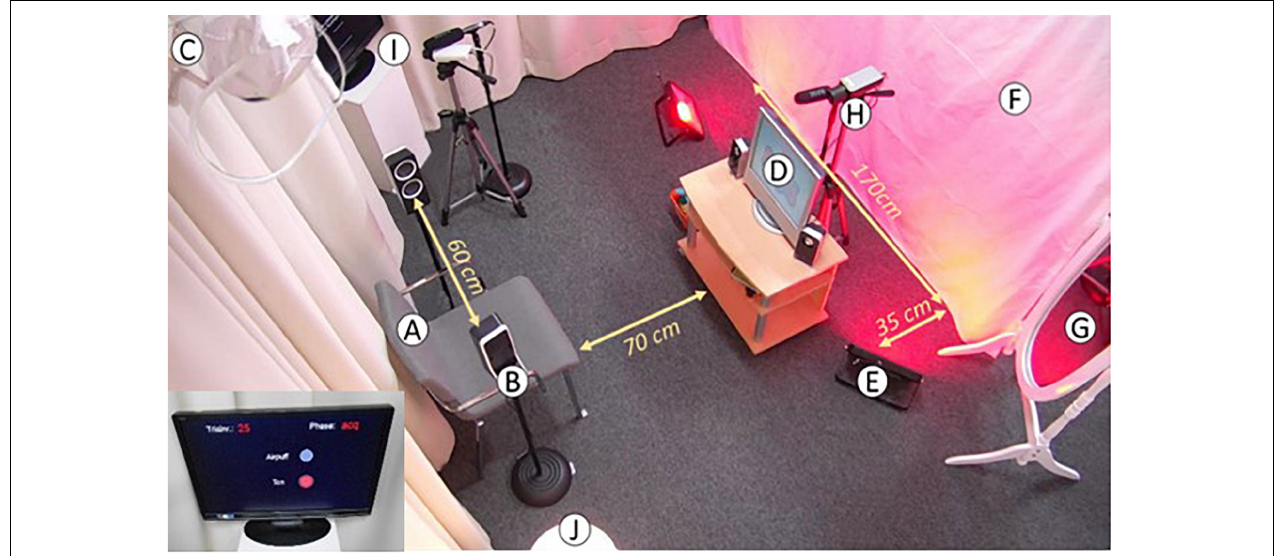
FIGURE 2 | Overview of the setup in the testing room. (A) Chair on which caregiver and infant are seated. (B) Two speakers to deliver the tone. (C) Headband. (D) Screen to display the video. (E) Two LED lights to illuminate the wall. (F) White cloth that is illuminated in different colors depending on context. (G) Mirror where caregiver can monitor infant. (H) Camera filming the infant’s head to record eyeblinks. (I) Camera filming the paradigm that displays the trial. (J) Lamp to illuminate the